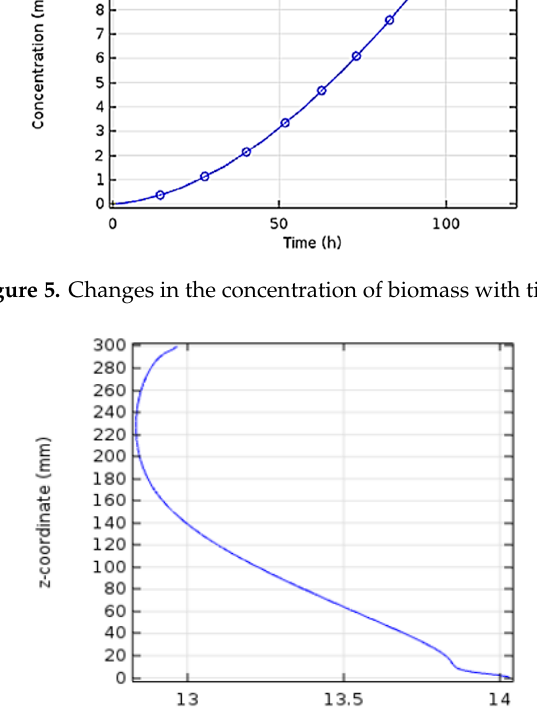
Figure 6. Linear changes of the reactor location concentration.